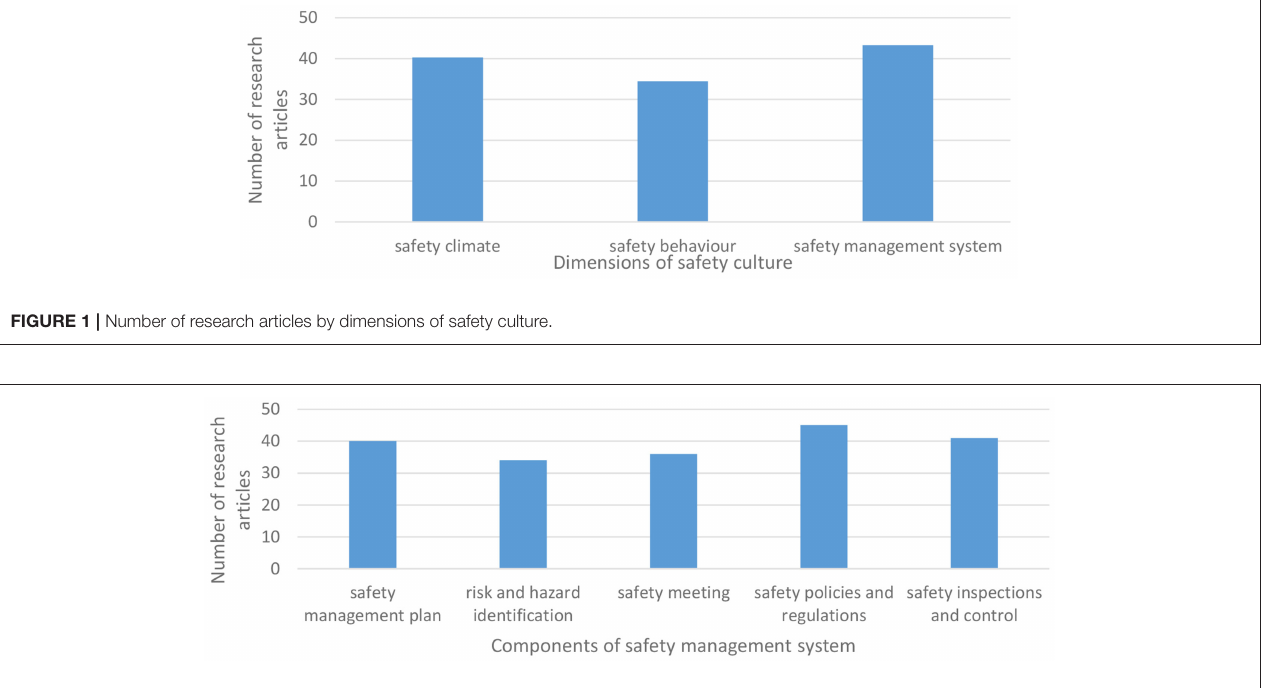
FIGURE 2 | Number of research articles by the safety management